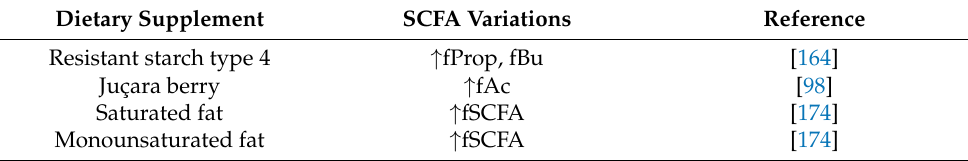
Table 4. Cont. Dietary Supplement SCFA Variations